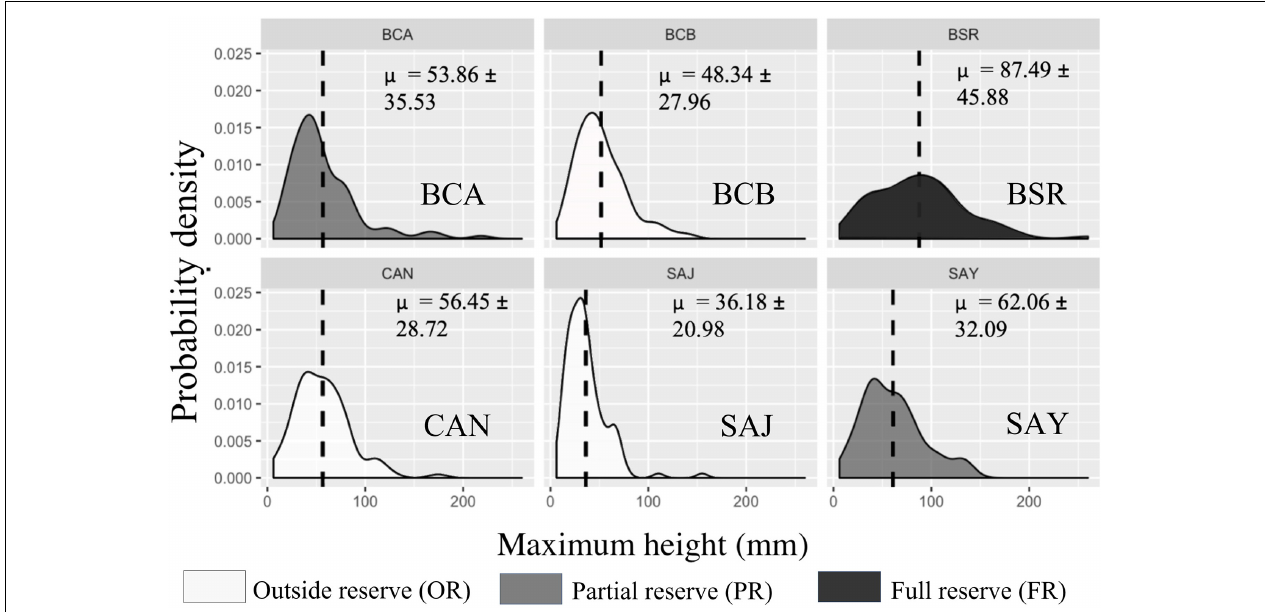
FIGURE 4 | Cerbère-Banyuls reserve: representation of probability density functions by population of each site for the variable maximum height (mm) in 2020. The values indicated correspond to the means followed by the standard deviations. In dark the population in full reserve (BSR), in medium the populations in partial reserve (BCA, SAY), in clear the populations outside the reserve (BCB, CAN, SAJ).